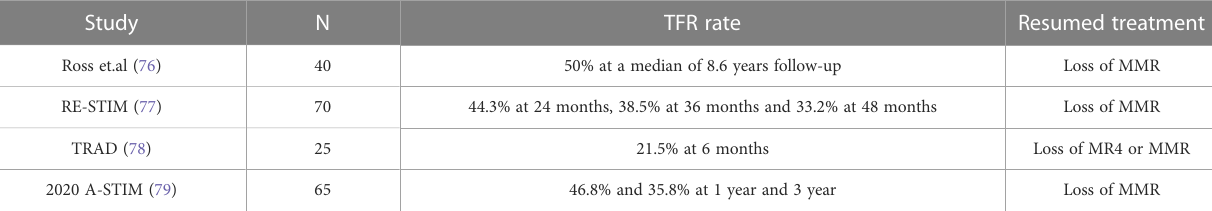
TABLE 3 Characteristics of secondary TFR